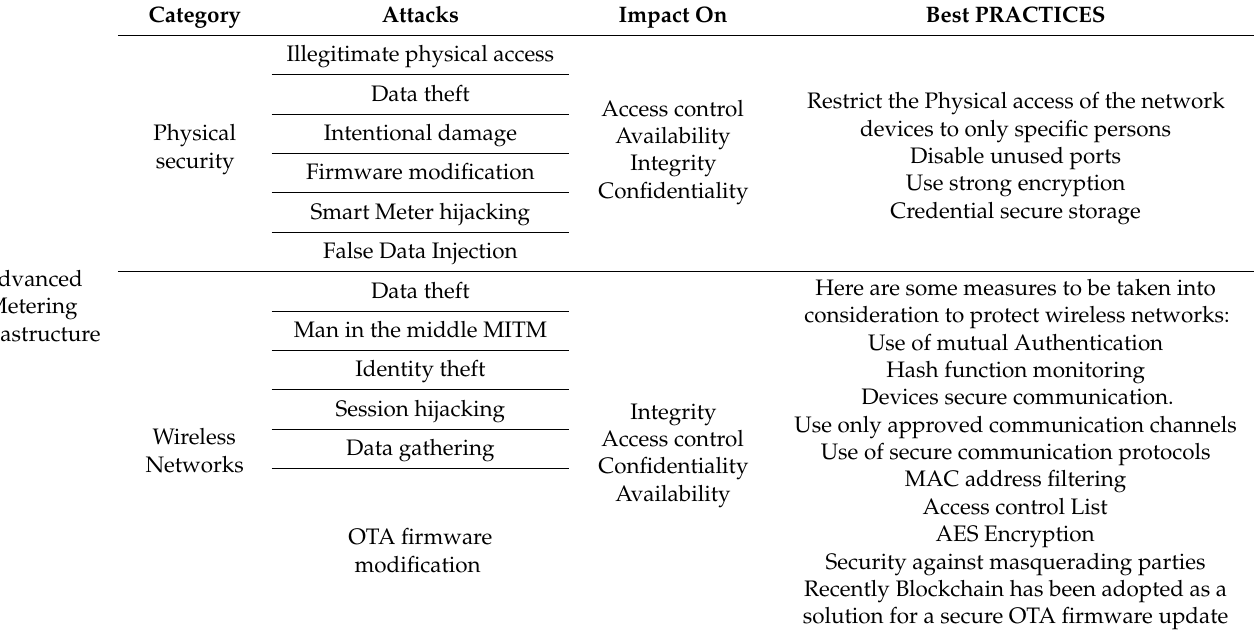
Table 1. Attacks on Smart Meter devices, wireless communication technologies, and communication networks and practices to avoid